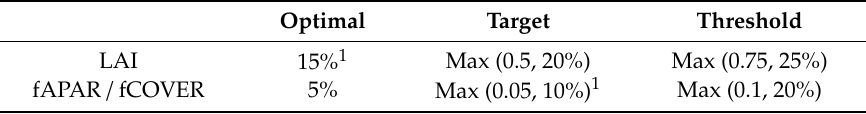
Table 4. Uncertainty requirements considered for LAI, fAPAR and